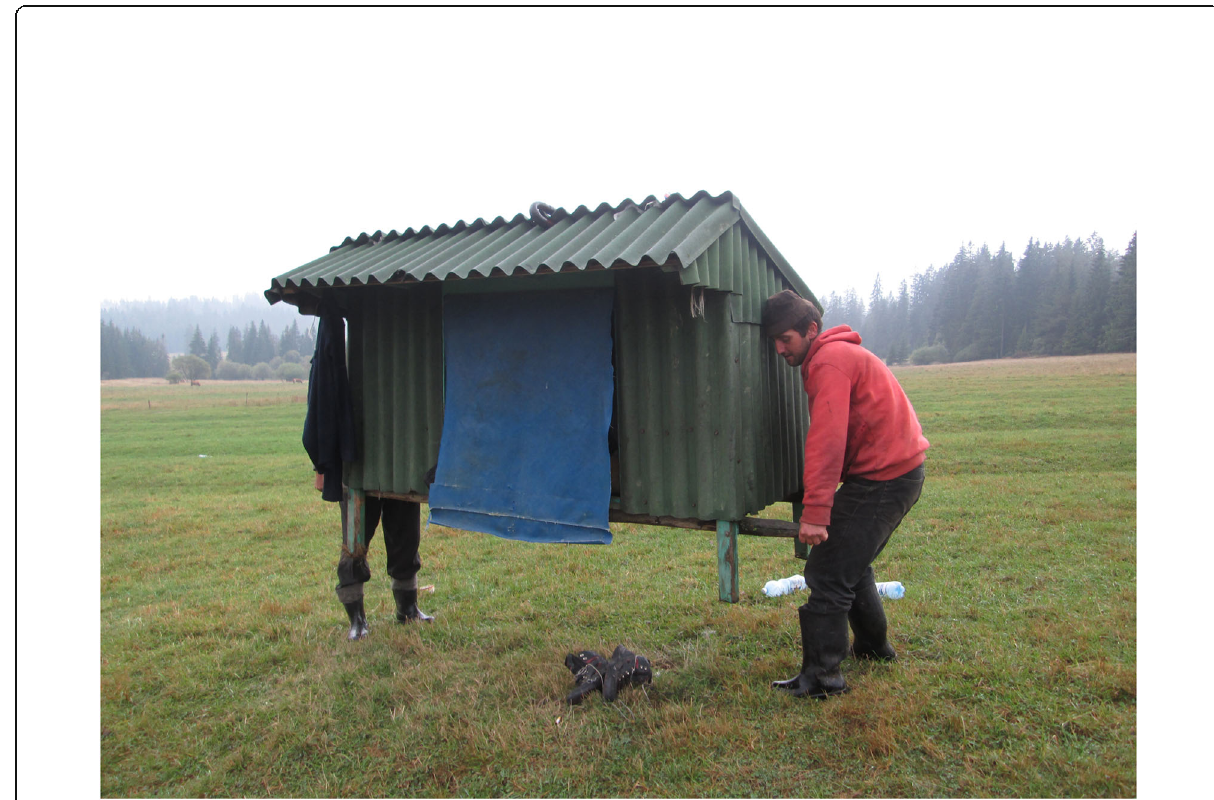
Figure 3 Portable shepherd ’ s shelter for staying with sheep at night. New materials, traditional